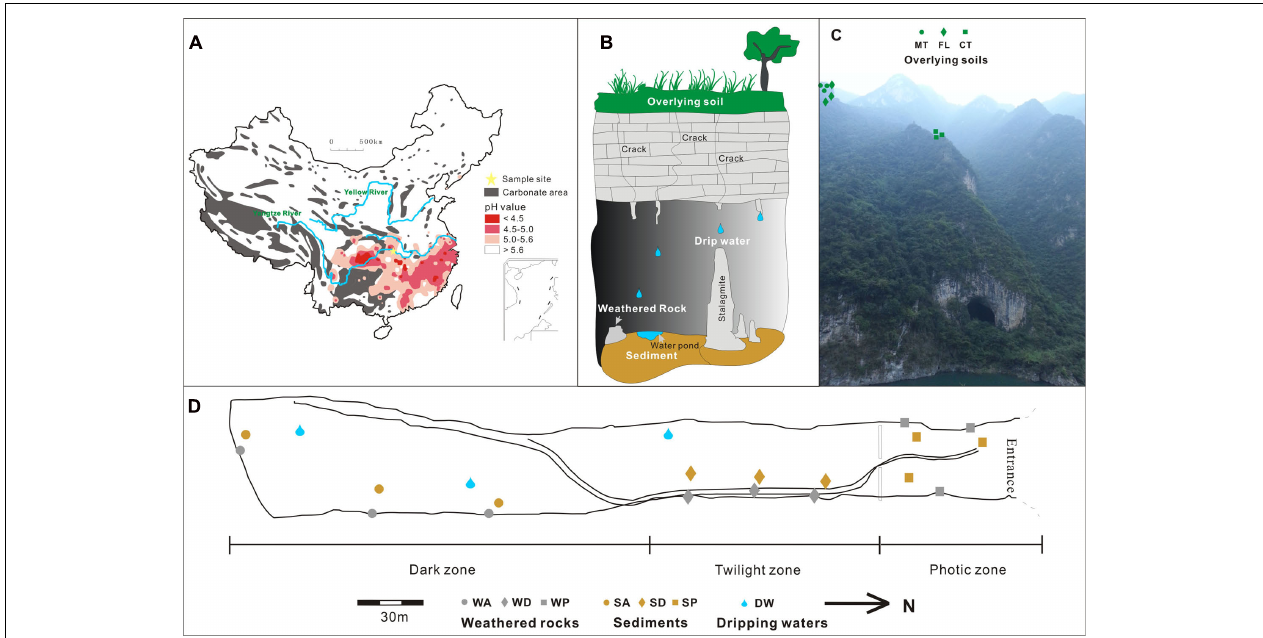
FIGURE 1 | Location of study site on the map of carbonate and acid rain distribution in China (A) modified after http://english.mep.gov.cn/standards_ reports/soe/soe2011/201307/t20130712_255427.htm and Yuan and Cao (2008) (B) . The schematic of the vertical section of Heshang Cave ecosystem, Hubei Province, central China, modified after Yang et al. (2011) and sampling sites outside and inside Heshang Cave are shown in (C,D) , respectively. Different colors denote samples of overlying soil (green), weathered rock (gray), sediment (brown), and dripping water (blue). MT, soils on the mountaintop; CT, soils above the cave; FL, soils from the nearby farm land; WA, weathered rocks in dark zone; WD, weathered rocks in twilight zone; WP, weathered rocks in photic zone; SA, sediments in dark zone; SD, sediments in twilight zone; SP, sediments in photic zone; DW, drip